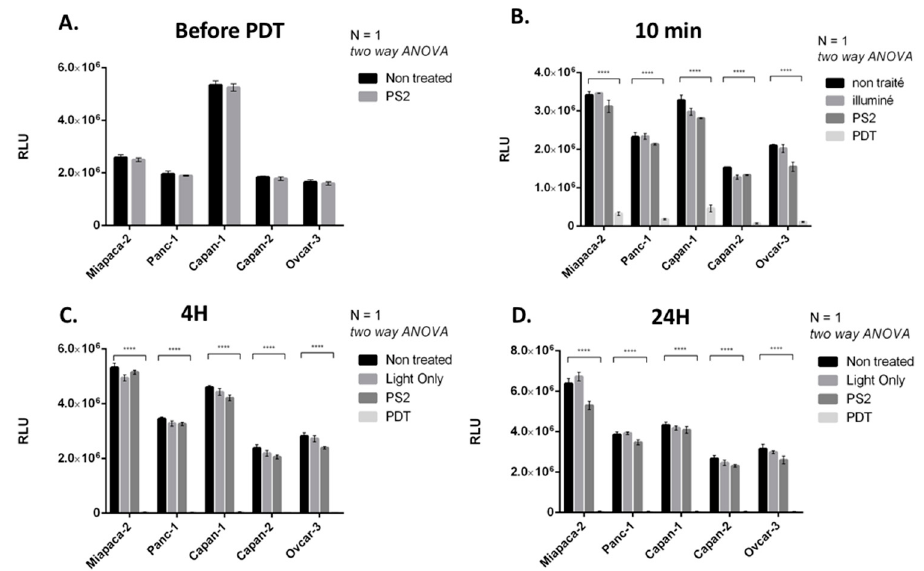
Figure 3. Impact of PS2-PhotoDynamic Therapy (PDT) on the four PDAC cell lines and one ovarian cancer viability. ( A ) Before illumination, ( B ) 10 min after illumination, ( C ) 4 h after illumination, and ( D ) 24 h after illumination. All quoted p -values are two-sided, with p ≤ 0.00001 (****) being considered statistically significant for the first and highly significant for the others.